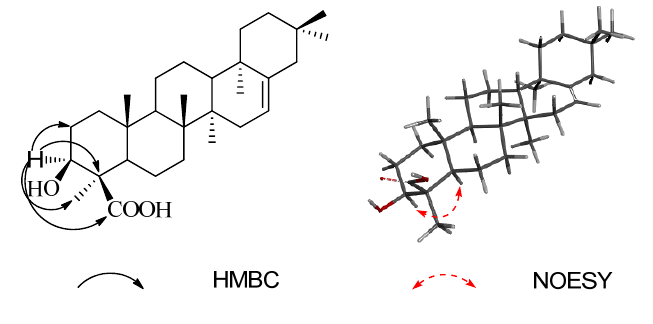
Figure 2. Key HMBC, and NOESY correlations of compound 1